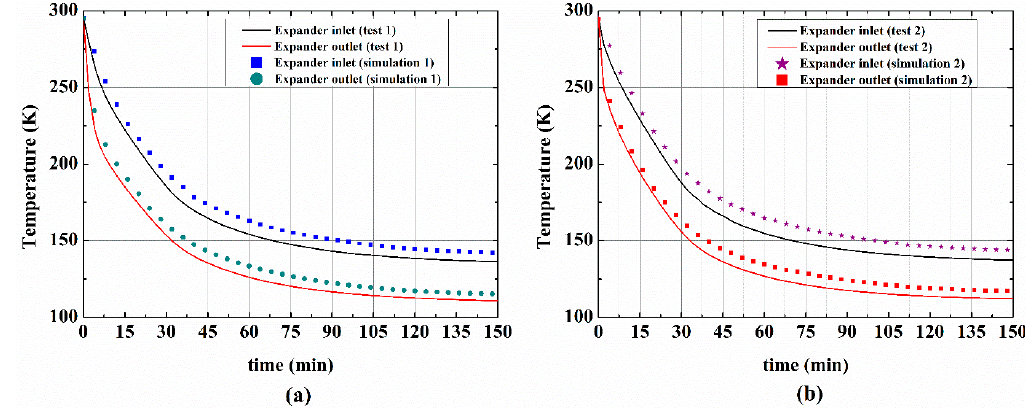
Figure 11. Experiment study: ( a ) Optimal expander efficiency; ( b ) certain brake